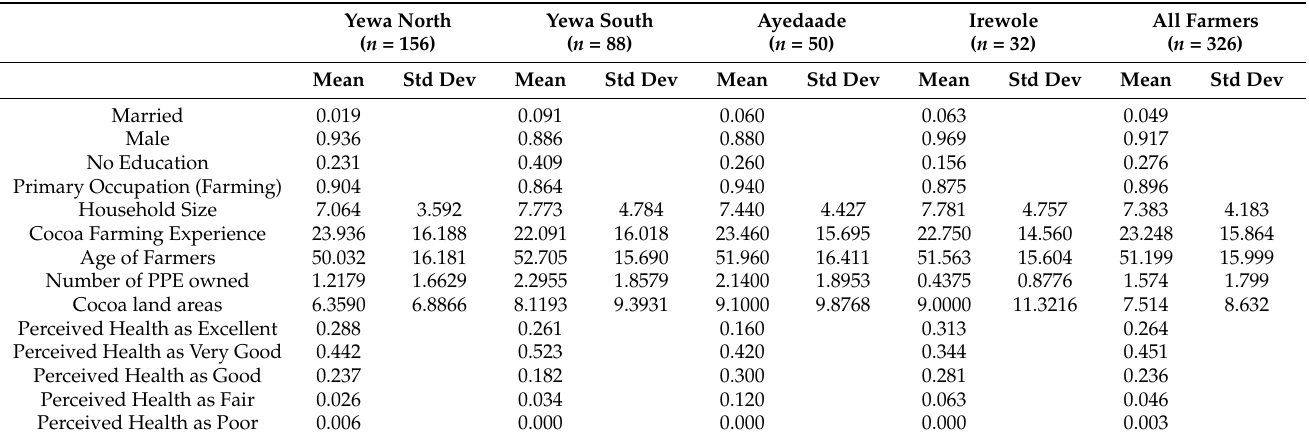
Table 2. Descriptive statistics of cocoa farmers’ selected demographic characteristics. Yewa North ( n = 156)